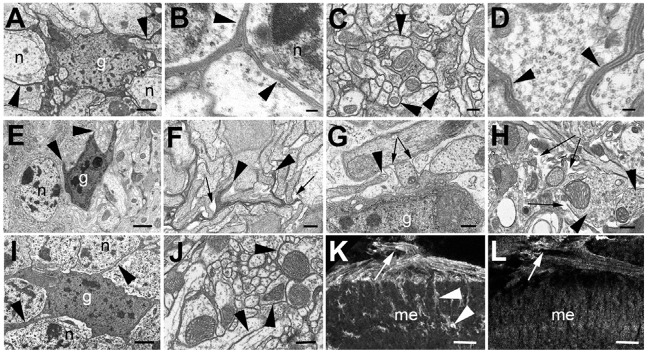
Loss of glial wrapping in the glial knockdown. (A-D) In a 14-day-old wild type, glial cells (g) extend processes (arrowheads) that enwrap neuronal cell bodies (n) (A,B) and neurites (C,D). (E,F) In a 14-day-old mz0709-GAL4;swsGD fly, glia show stunted processes (arrowheads) leading to a loss of glial ensheathment of neuronal cell bodies (n in E) and neurites (F). In addition, small empty spaces occur between neurites (arrows in F). (G) A glial cell body in a 1-day-old repo-GAL4;swsGD fly has only extended a short process (arrowhead), leading to incomplete wrapping of neurites and gaps between neurites (arrows). (H) When aged for 14 days, the spaces between neurites have widened (arrows) and many neurites are filled with vesicles (arrowheads). (I,J) Knocking down SWS with alrm-GAL4 and swsGD did not result in detectable changes in glia or neurite morphology. Arrowheads point to glial processes. (K) Inducing mCD4-GFP with mz0709-GAL4 reveals that this glial cell type sends processes into the neuropil (arrowheads; fly was 14 days old).  Arrow points to the first optic chiasm. (L) In a 14-day-old mz0709 mCD4-GFP, GAL4;swsGD fly these processes are not detectable and only processes along the first optic chiasm are still detectable (arrow). Scale bars in A,E,I: 1 µm, in B,D: 100 nm, in C,F-H,J: 0.5 µm, in K,L 10 µm. me, medulla.